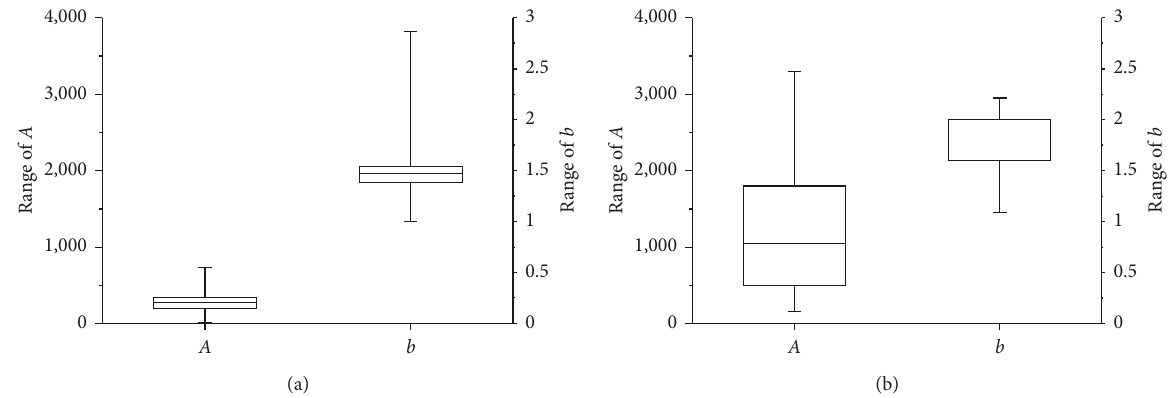
Figure 1: Comparison of the (a) Z - R and (b) Z - S relationships with their box plots of parameters A and b